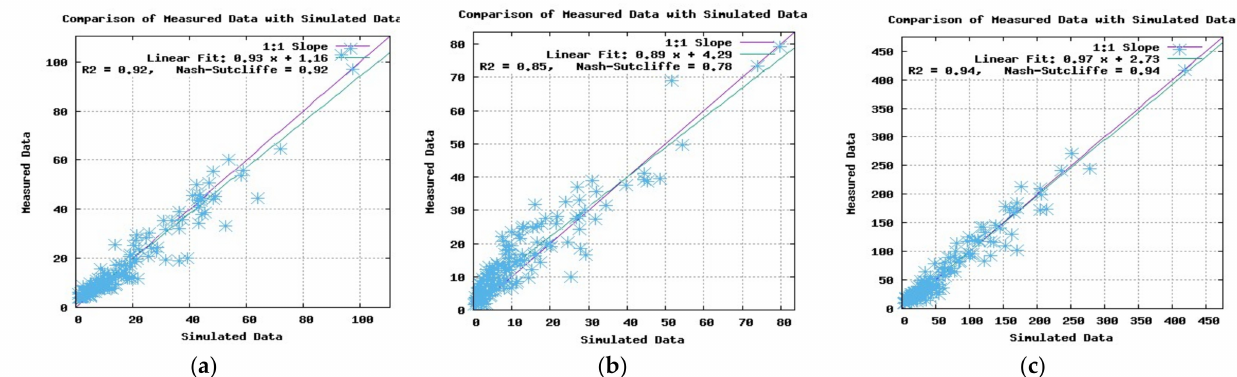
Figure 3. Scatter plot and objective functions for validation period for ( a ) Choccolocco Creek at Jackson Shoal near Lincoln at USGS Gage 02404400, ( b ) Little Tallapoosa River near Newell near Newell at USGS Gage 24133000, and ( c ) Cahaba River near Marion Junction at USGS Gage 02425000.